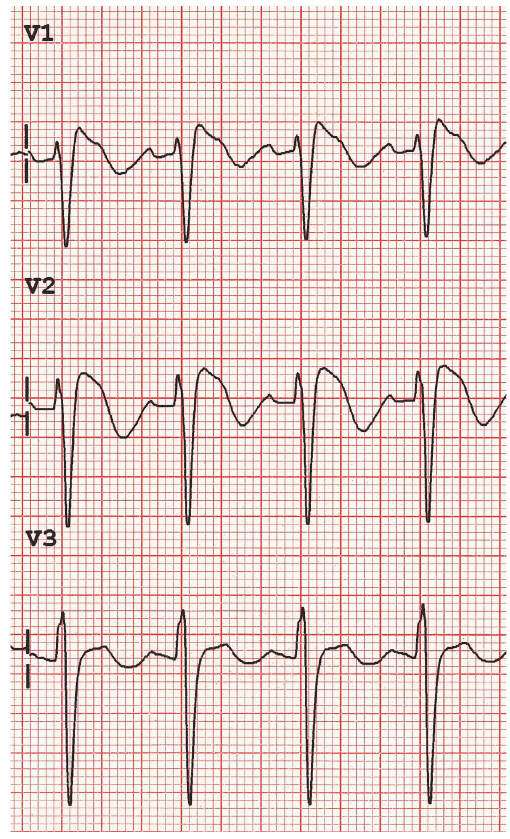
Figure 1: Brugada-like ECG changes that may be seen in propofol infusion syndrome. Coved ST elevation, at least 2mm J point elevation and descending ST segment followed by a negative T wave (see